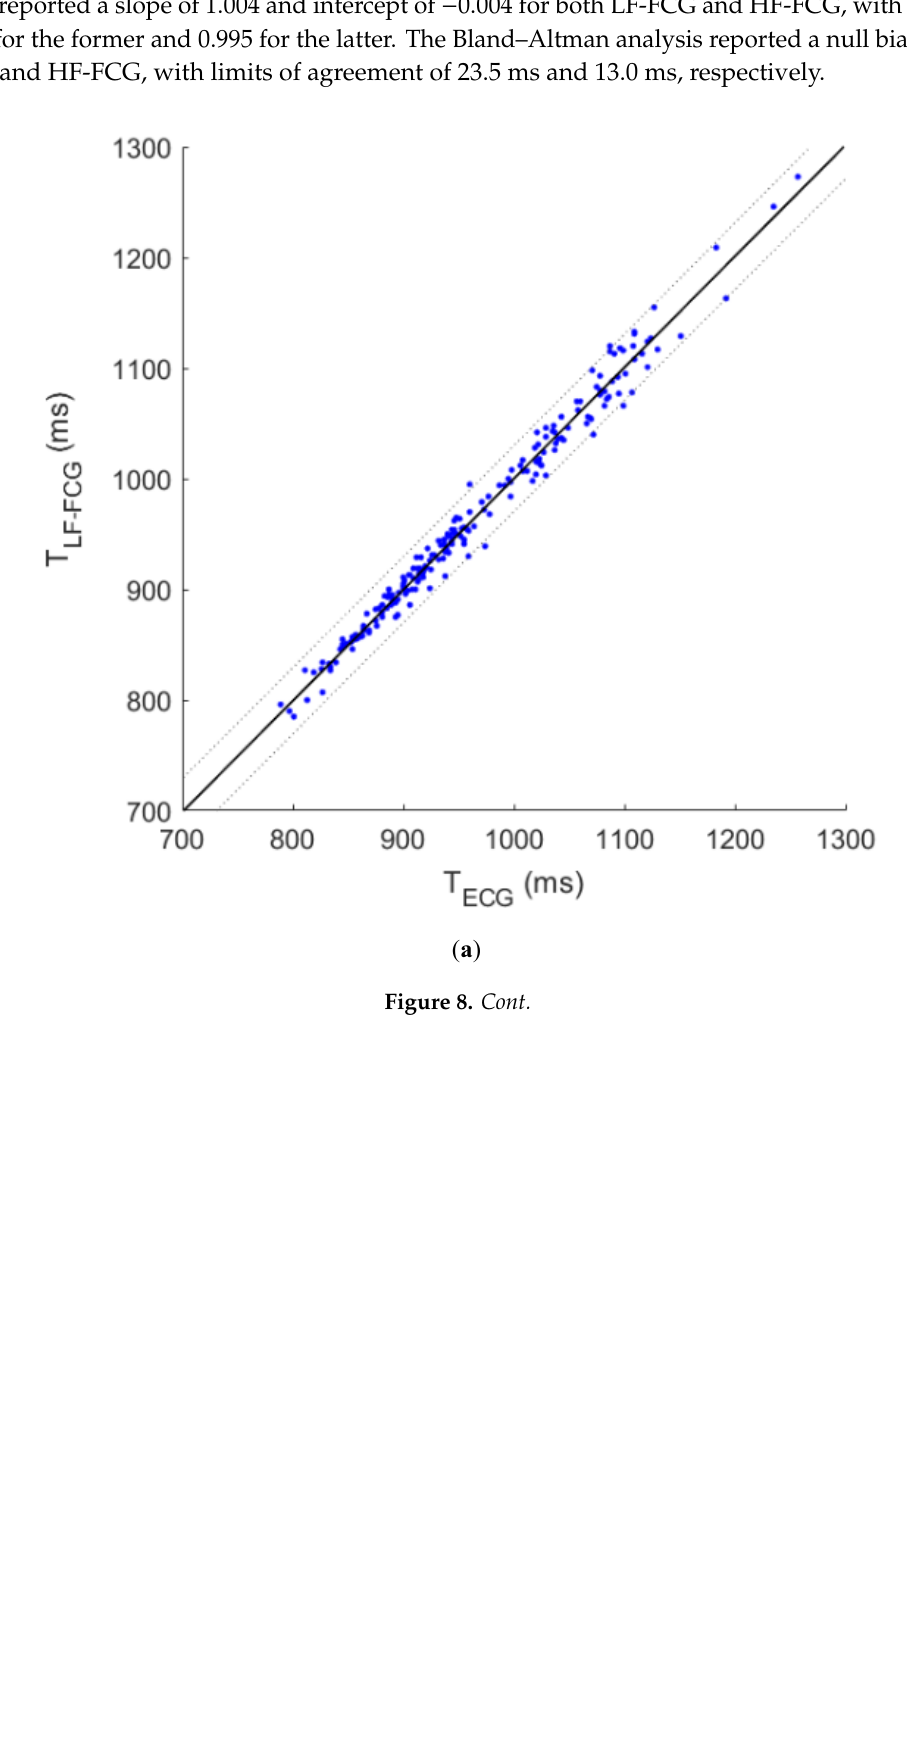
Figure 7. Subject #5 dataset. (a) Excerpt of ECG and LF-FCG signals (3 consecutive heartbeats) showing fiducial points located on LF-FCG; (b) excerpt of ECG and HF-FCG signals (same 3 consecutive heartbeats) showing fiducial points located on